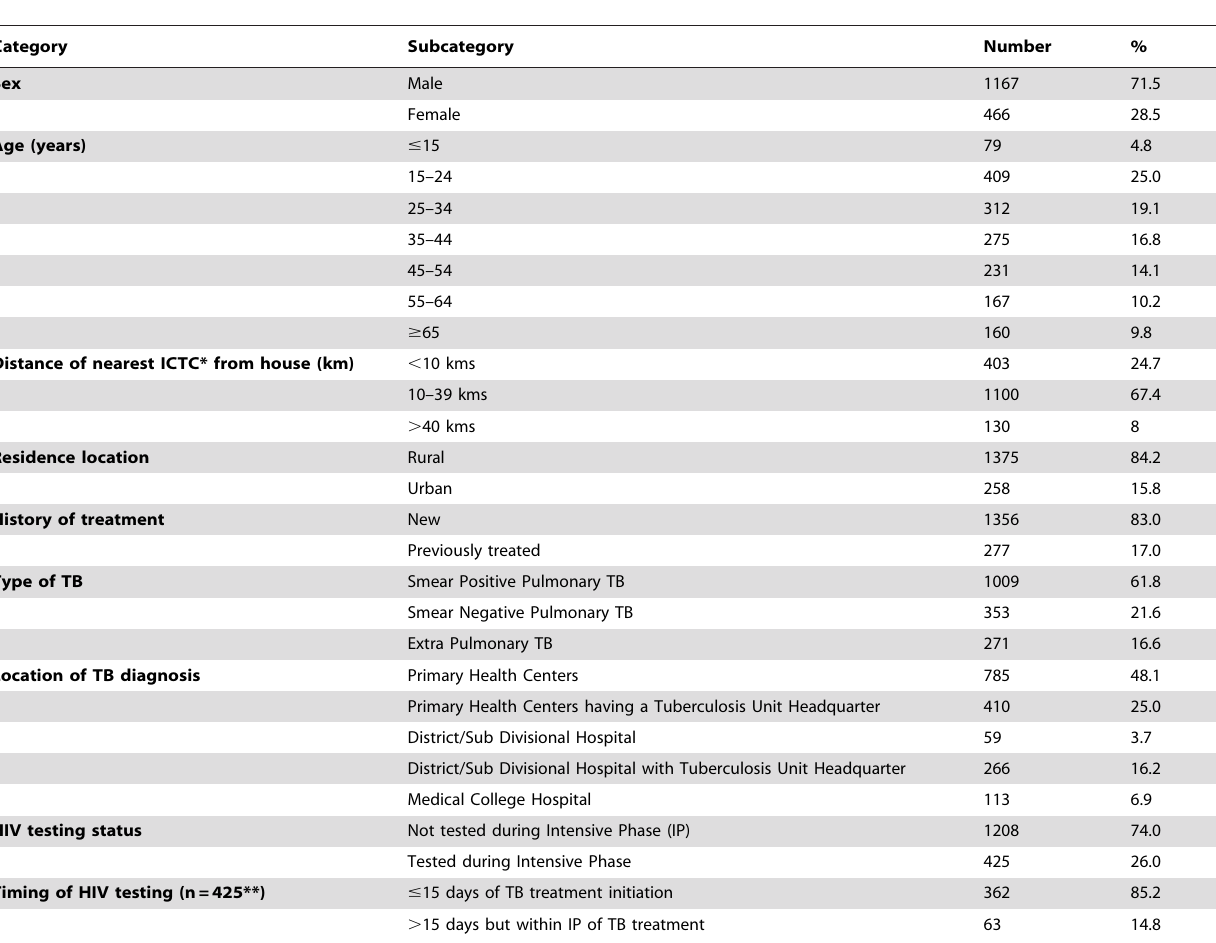
Table 1. Demographic and clinical characteristics of patients with TB (n=1,633) registered for treatment from July – September, 2010 in South 24 Parganas District, West Bengal State,